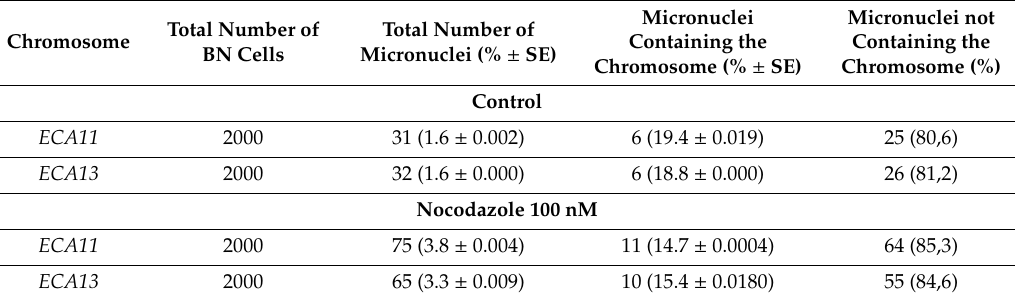
Table 4. Cytokinesis-Block MicroNucleus assay under mitotic